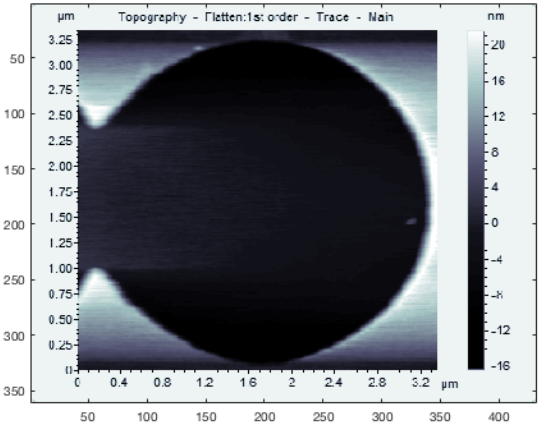
Figure 4. Raster image of circular grating showing the “doubling” effect due to transient dynamics in the cantilever at the sharp turnaround of the raster